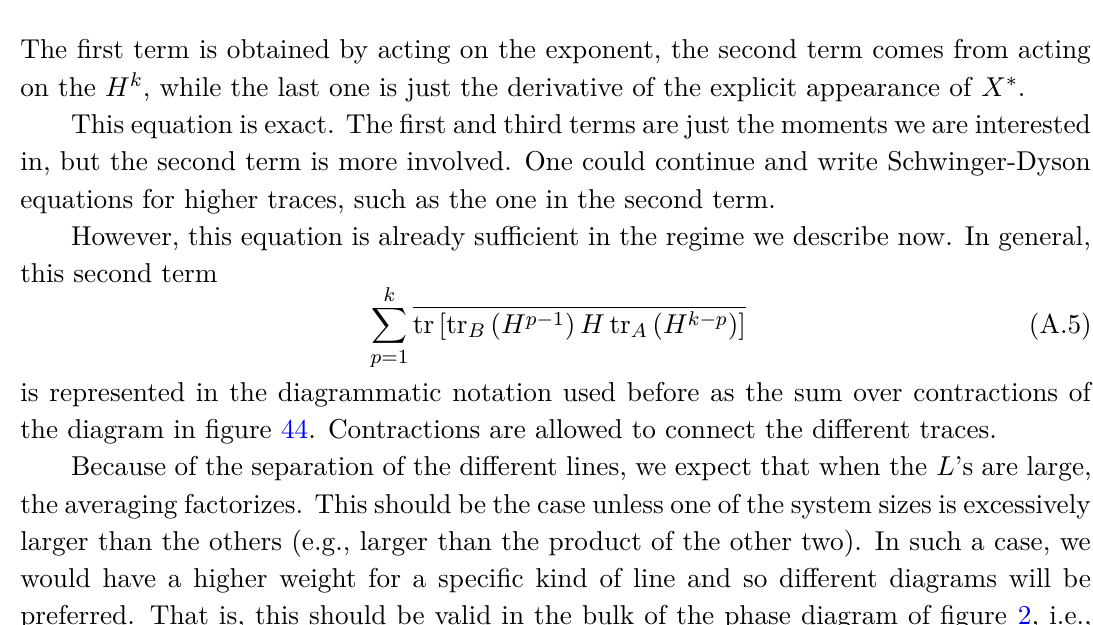
Figure 45 . A factorized form of figure